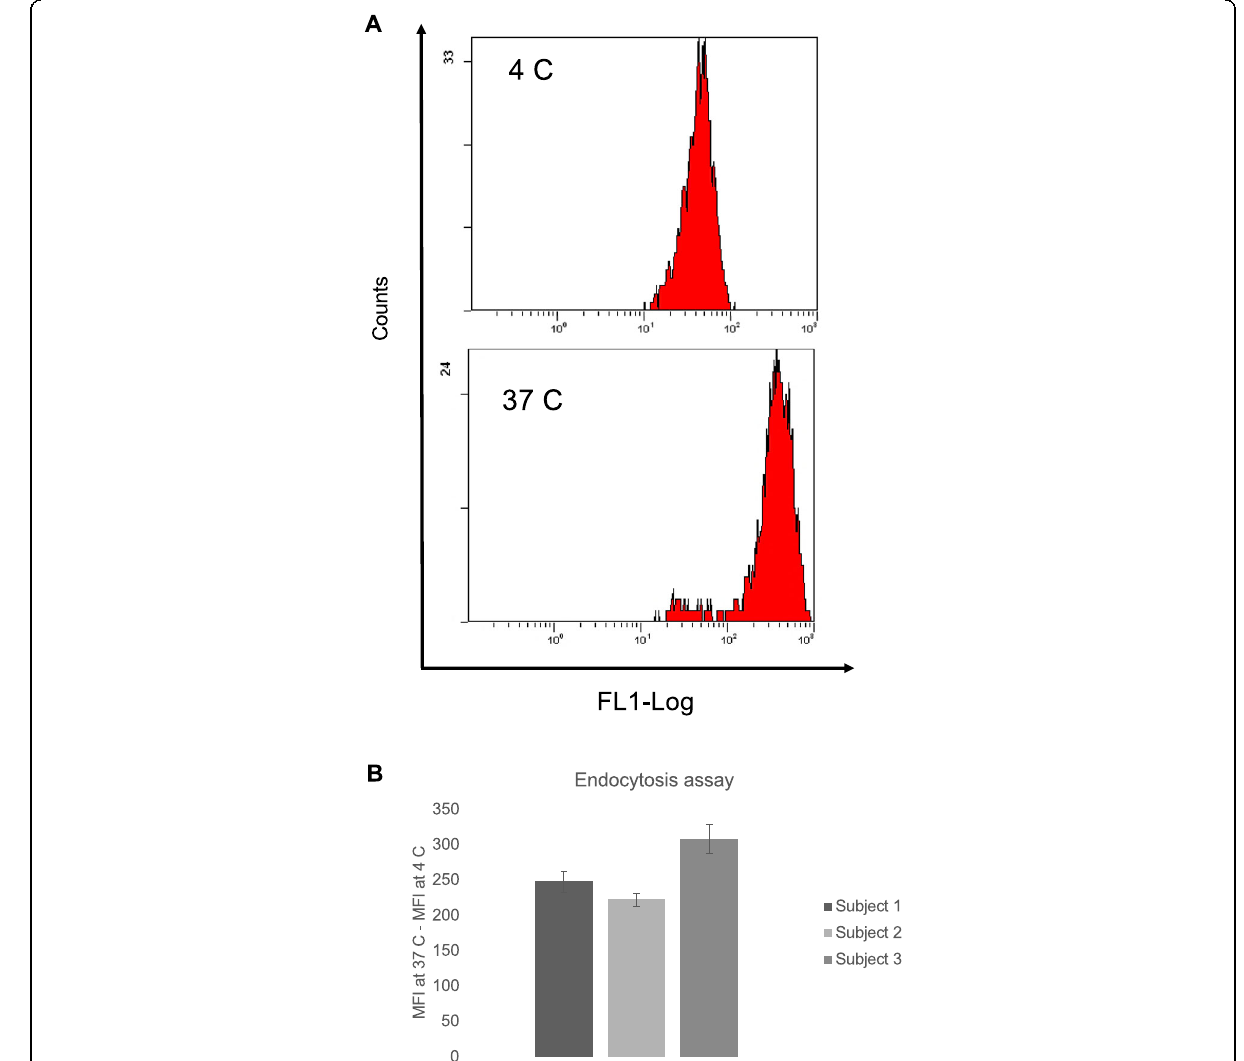
Fig. 1 Endocytosis assay. a mature DC were incubated with the endocytic tracer (Dextran 10,000 m.w. conjugated with Alexa Fluor 488, Al488- dextran). The amount of Al488-dextran that was taken up by the DC was measured as fluorescence intensity using a FC500 flow-cytometer. The assay was conducted at 4 C as a negative control for endocytosis. b The MFI (Mean Fluorescence Intensity) was measured in triplicate assays at 37 C and 4 C. The average net MFi (37 C – 4 C) +/ − 95% C.I. is shown for 3